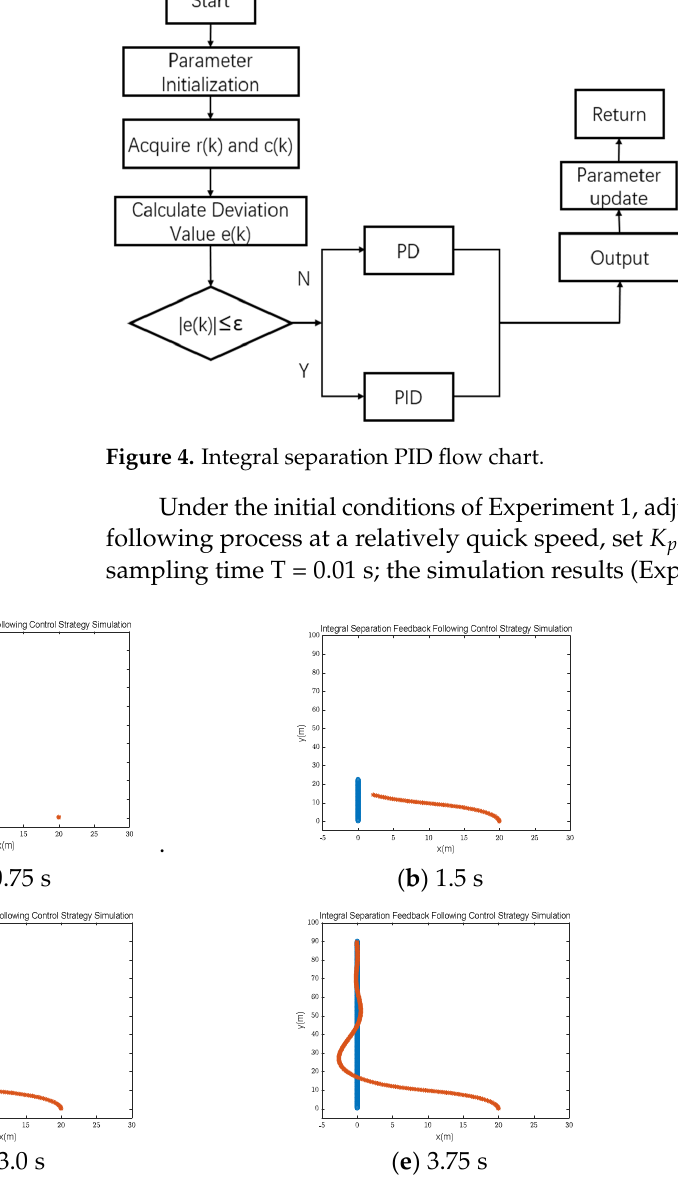
Figure 4. Integral separation PID flow chart.